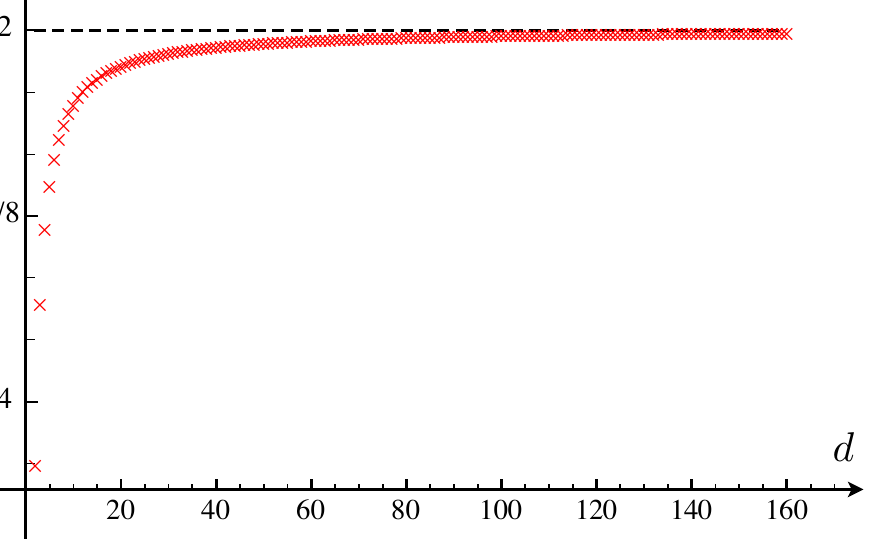
Figure 23 . The critical slope (cid:11) c ( d ) of the half plane Q as function of the dimensionality parameter d > 2. These points have been found by solving (C.13). The value (cid:11) c (2) is given by (5.6). We (cid:12)nd that (cid:11) c ( d ) ! (cid:25)= 2 as d ! + 1